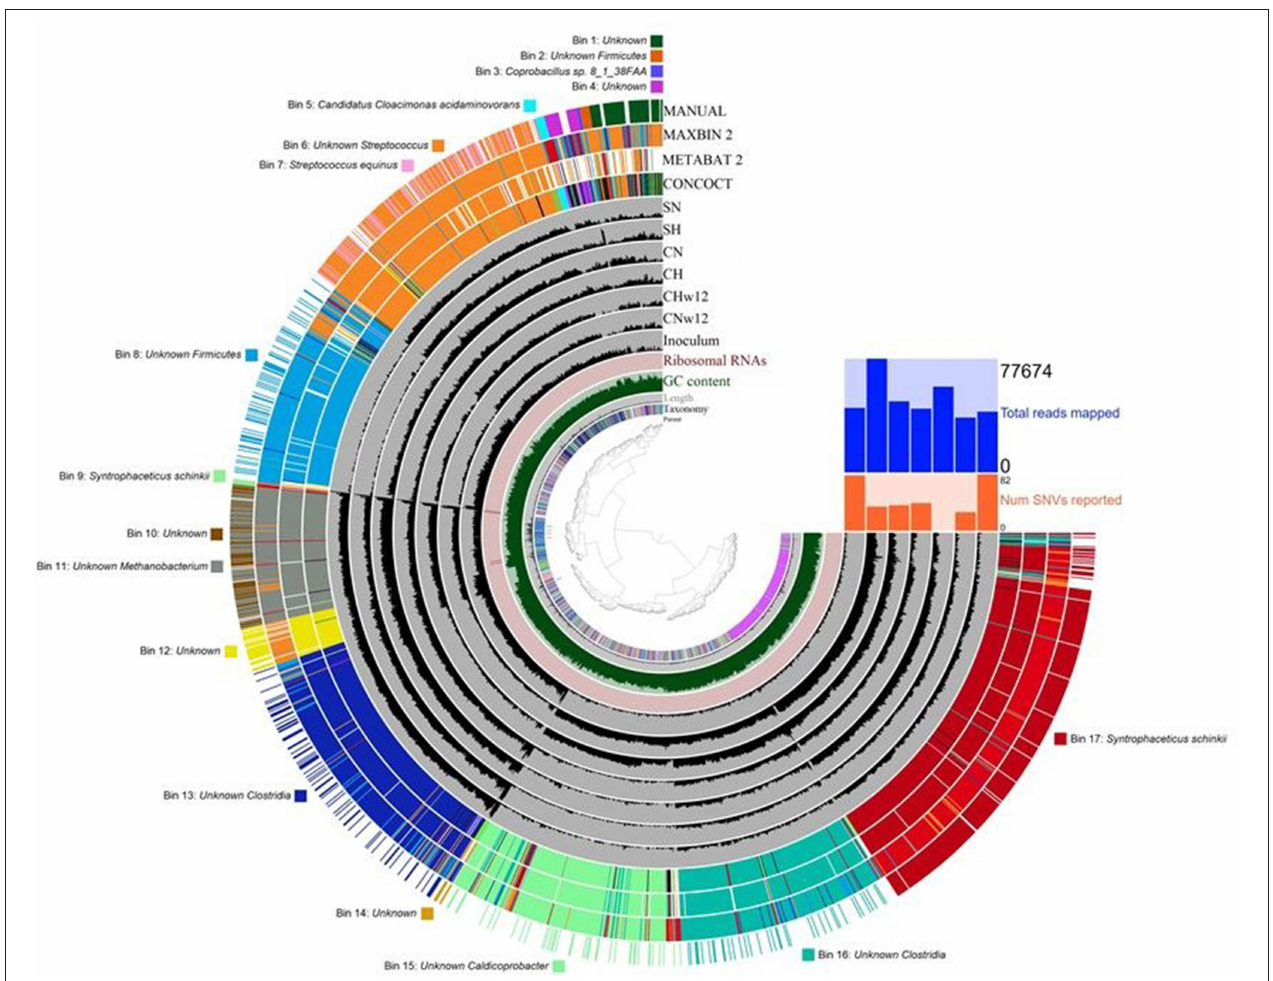
FIGURE 8 | Results of the genome-based evaluation (binning) of sequencing data. The dendogram in the center displays the hierarchical clustering of contigs based on their sequence compositions. The layers from inside out are as follows: (1) The parent layer marks the splits originated from the same contigs with gray bars. (2) The Kaiju taxonomic layer shows the taxonomy for each open reading frame detected in a given split. (3) The length layer indicates the actual length of a given split. (4) GC-content layer. (5) Ribosomal RNA layer. (6) Gray layers represent every sample and each black bar is the coverage of a given split in a given sample. (7) Colored layers: CONCOCT, MAXBIN 2, METABAT 2 display the results of these automated binning methods, respectively, and the MANUAL layer indicates the manual refinement of the automated binning results. The bins and the corresponding taxa are listed around the figure. The compositions of the reactors were as in Figure 3